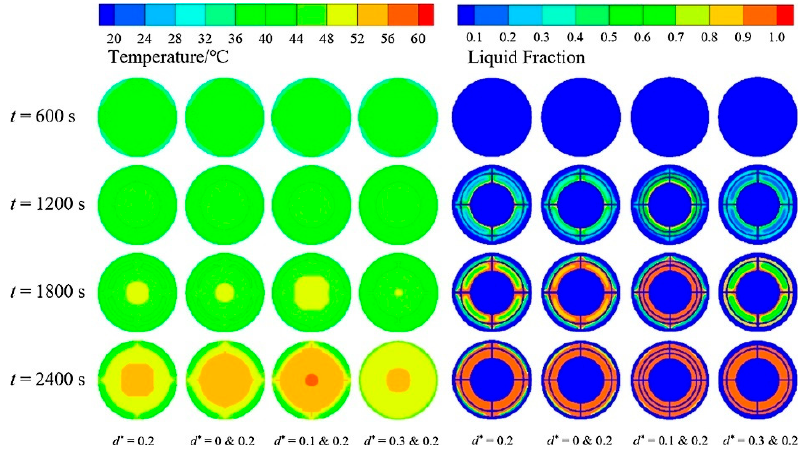
Figure 16. Temperature and LF distribution for one and two cylindrical rings [65]. Reproduced with permission from Elsevier.